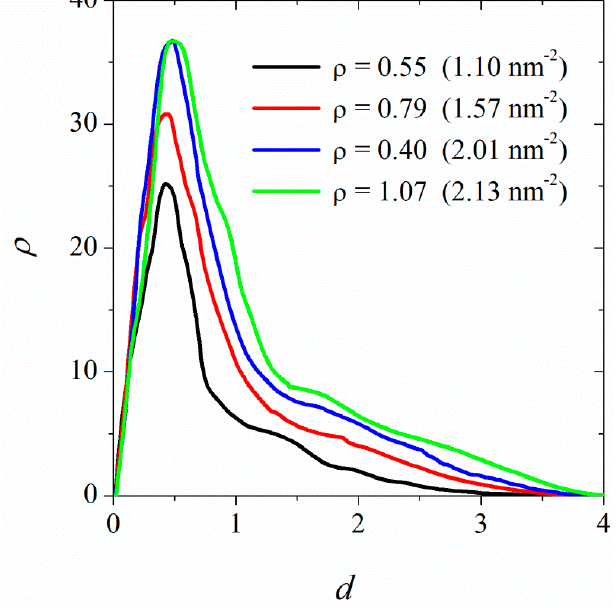
Figure 7. Number density profiles for DPPC molecules adsorbed on the surface of CNT (34, 34) as a function of distance from the CNT surface. The surface densities are shown in the figure legend. The highest density corresponds to surface saturation.